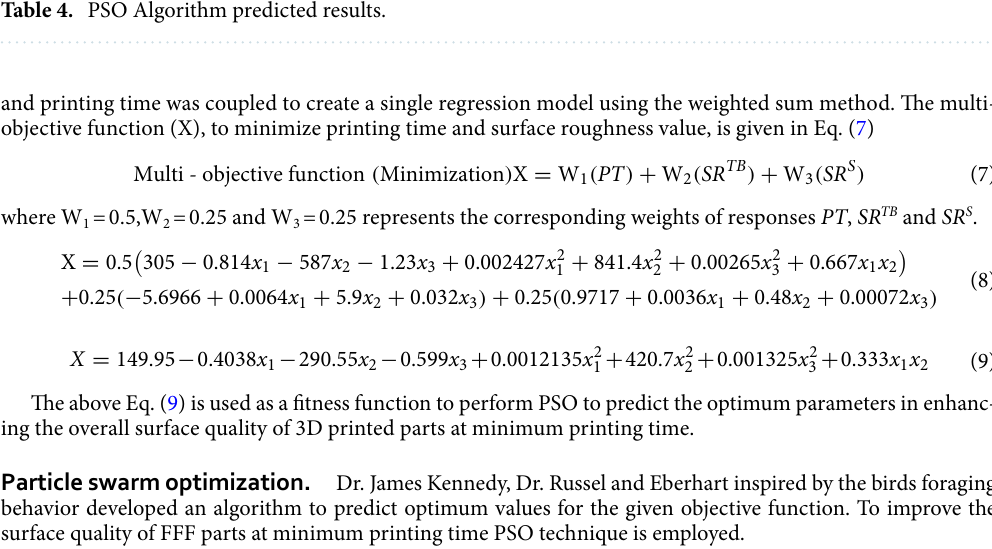
Table 4. PSO Algorithm predicted